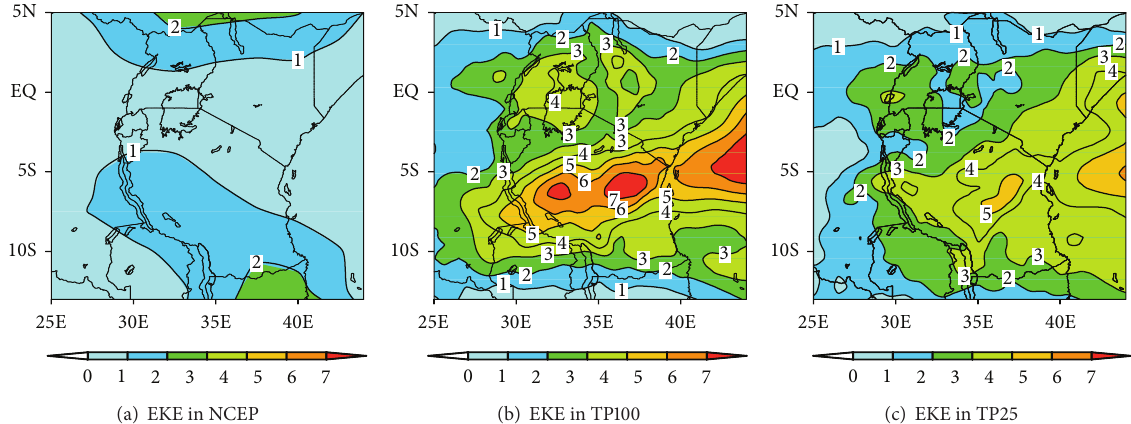
Figure 10: Spatial distributions of eddy kinetic energy (EKE in m 2 s 2 ) at 500 hPa, averaged during November 2006 from (a) NCEP reanalysis